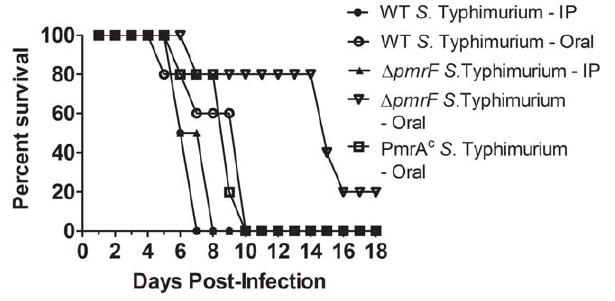
Figure 2. Survival analysis of BALB/c mice infected with WT or mutant S . Typhimurium. BALB/c (WT) mice were infected via the oral route with either 10 4 CFU of WT, D pmrF or PmrA c S . Typhimurium or with 10 2 CFU of WT or D pmrF S . Typhimurium via the IP route. The graph depicts representative results from the virulence assays, which were performed in